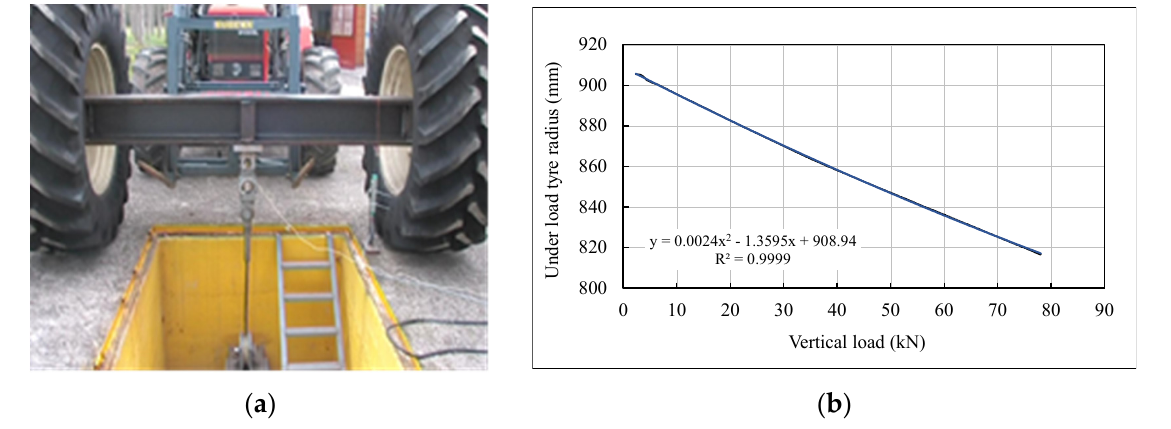
Figure 4. Preliminary tests for the determination of the load ‐ deflection curve: ( a ) Test plant: the tires are mounted on an axle realized on purpose; the load cell and the position transducer are visible. ( b ) Variations of the tire radius, as a function of the vertical load, obtained from the data of deflection, considering that at the inflation pressure of 0.16 MPa used in the test, the tire overall diameter is 1815 mm.